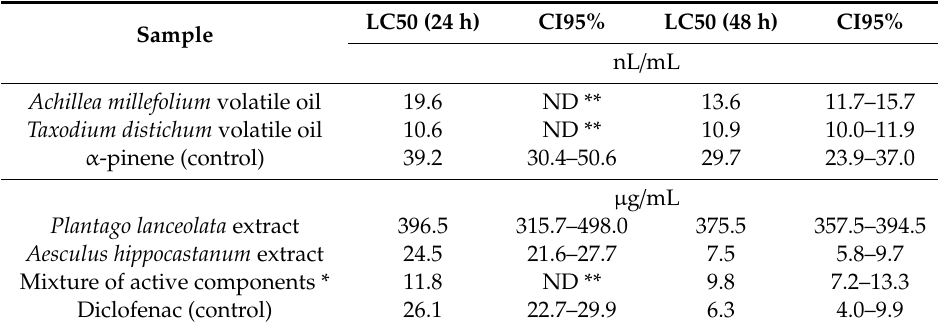
Table 2. Assessment of toxicity on Daphnia magna